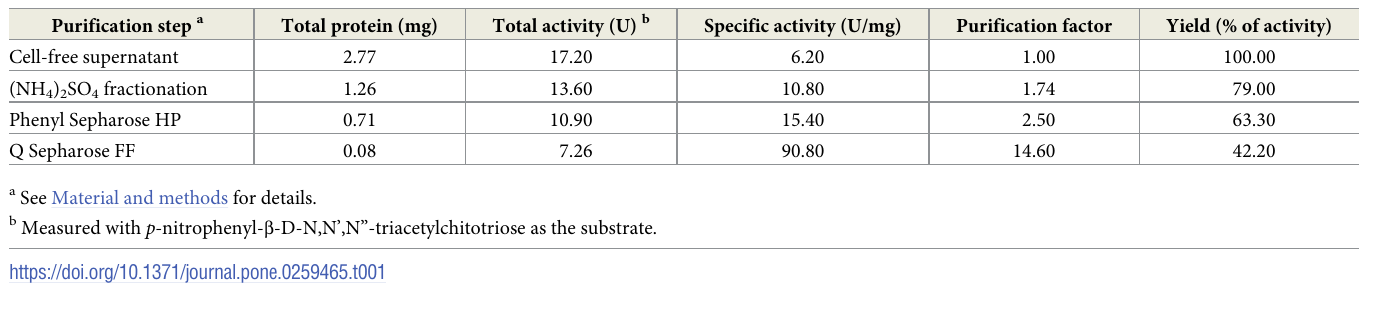
Table 1. Summary of purification of GH18 chitinase from Curtobacterium sp. GD1 culture